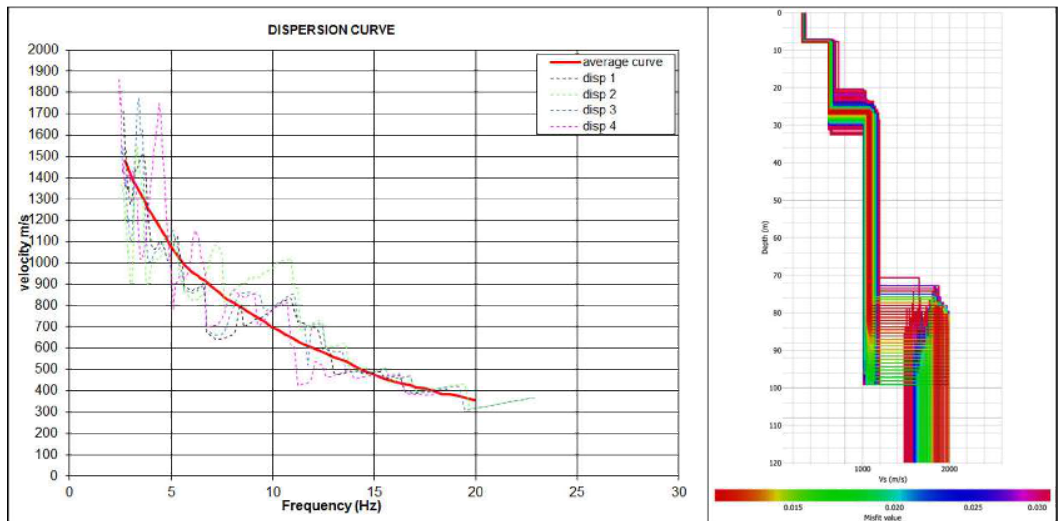
Figure 10:. Dispersion curve and VS profile estimated by ESAC analysis in Pescara del